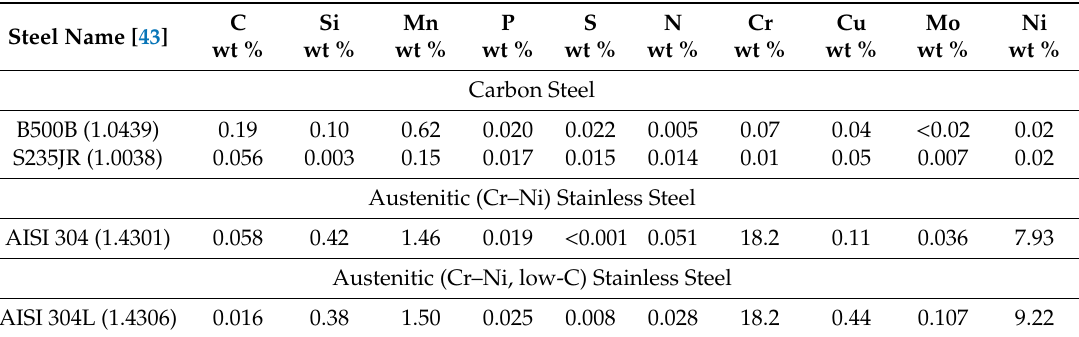
Table 2. Chemical composition of the tested steel